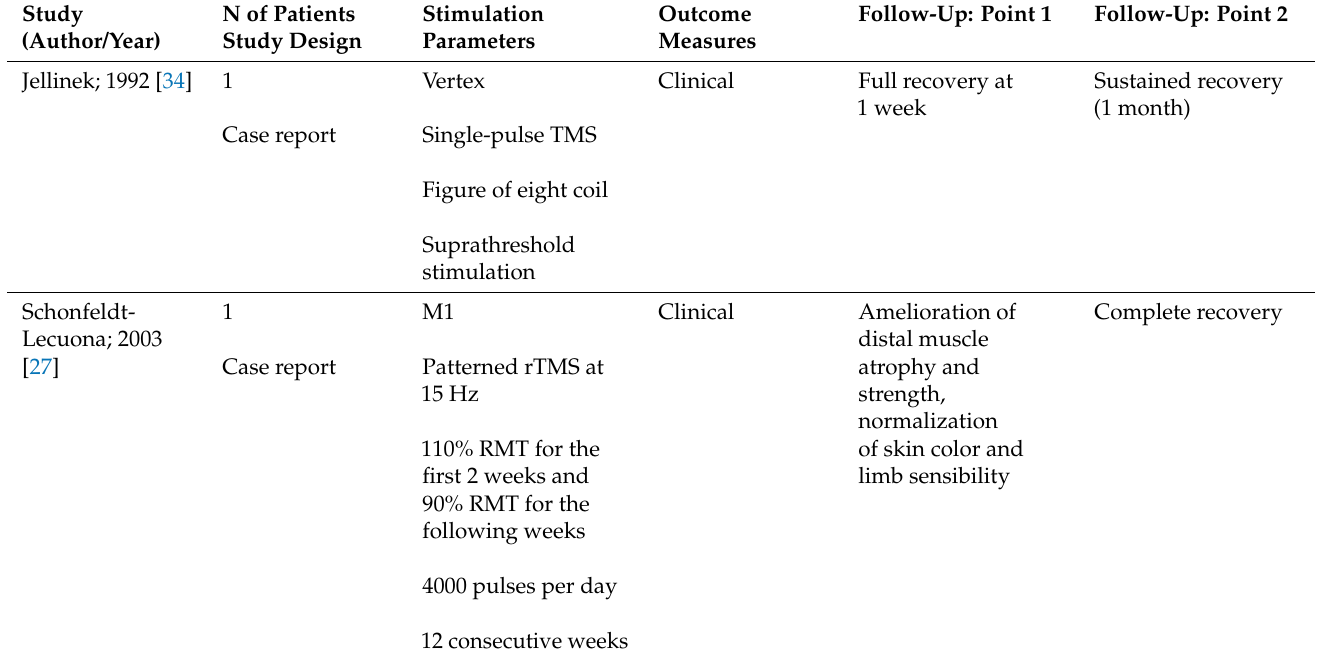
Table 2. Summary of therapeutical TMS studies on FP. CMCT: central motor conduction time;